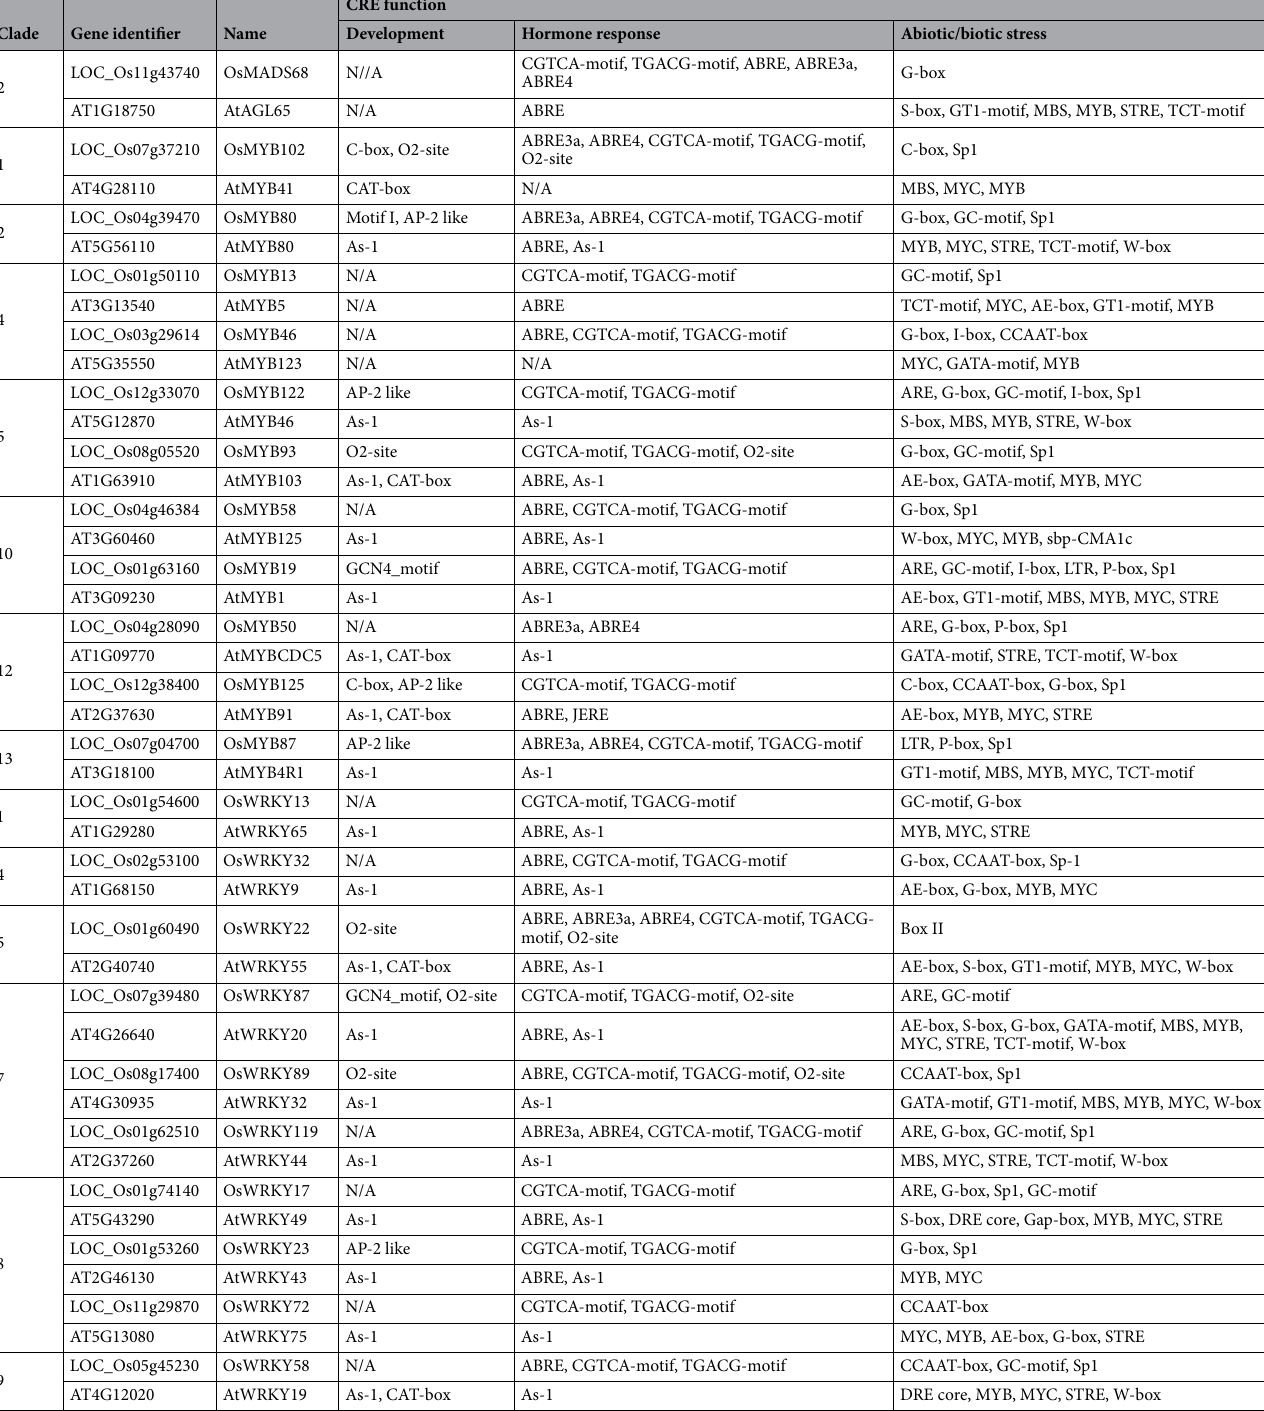
Table 2. Comparison of plant development, hormone and stress-responsive cis-regulatory elements ( CREs) in the promoter regions of Arabidopsis and rice WRKY, MADS-box, and MYB orthologous gene